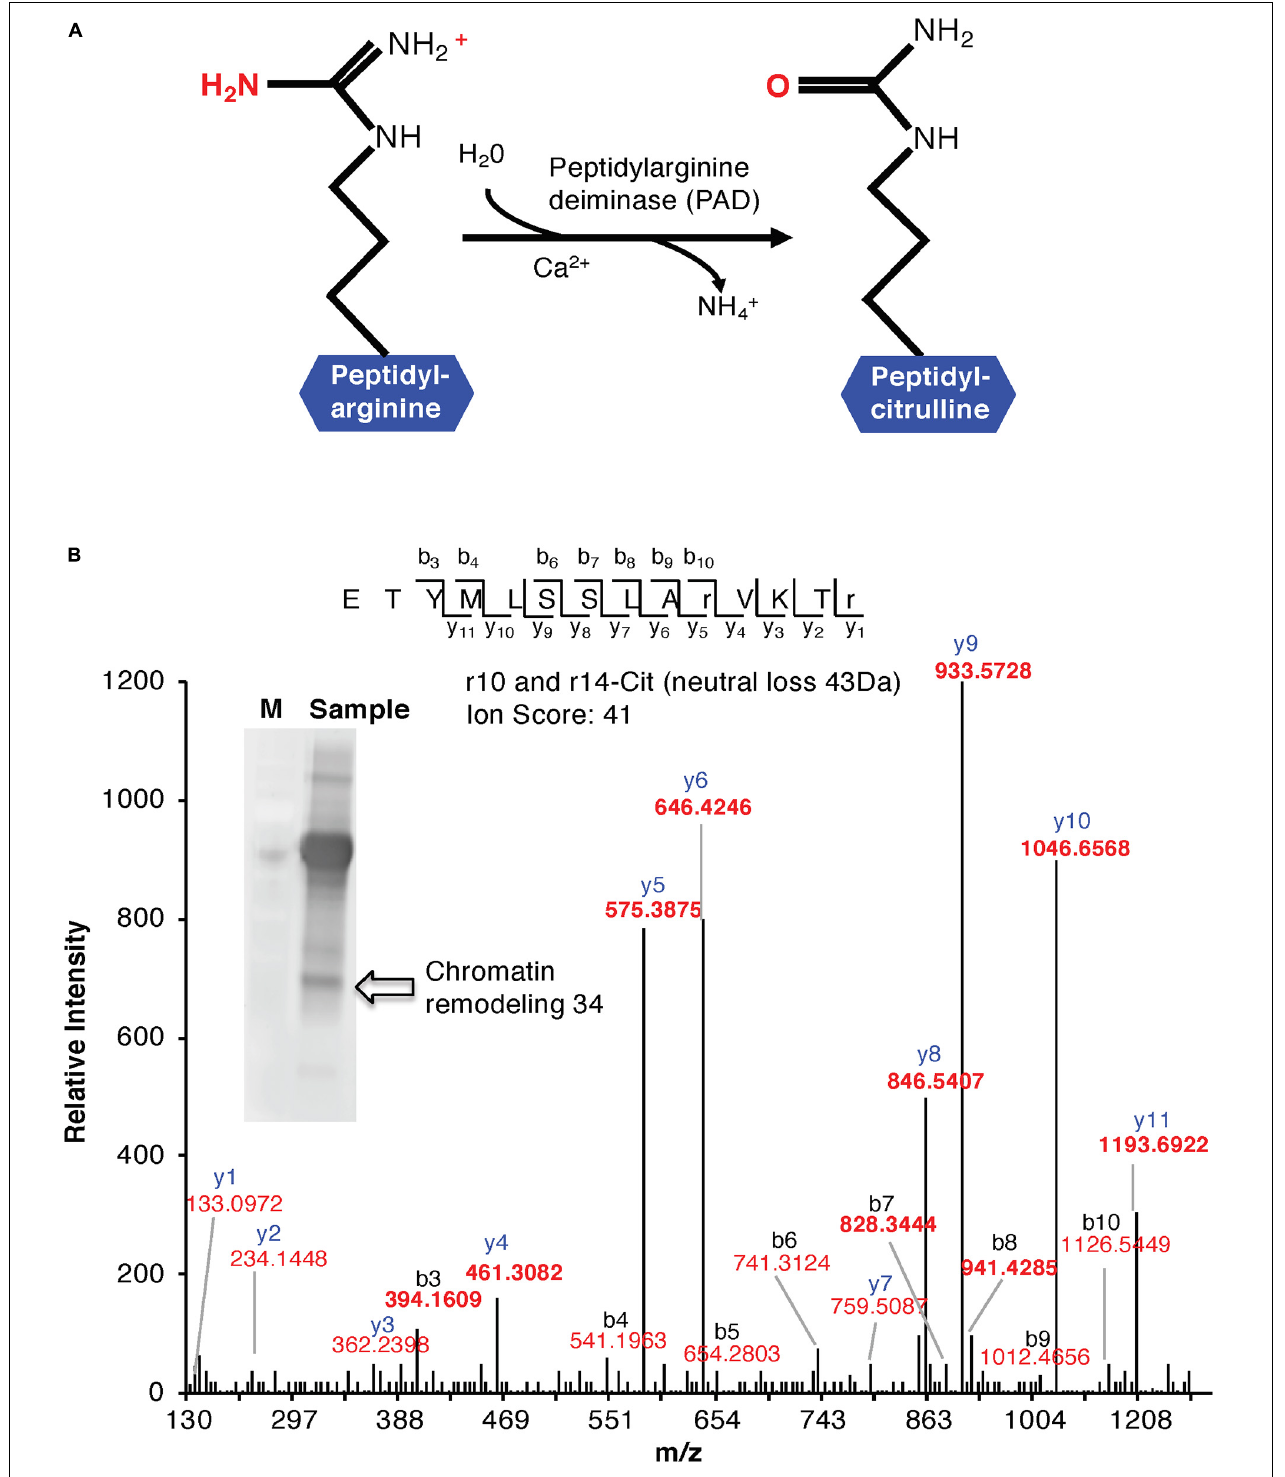
FIGURE 1 | (A) Enzymatic formation of a citrulline. Enzymatic hydrolysis of peptidyl-arginine to peptidyl-citrulline by peptidylarginine deiminase (PAD). (B) MS/MS spectra of a citrullinated Chromatin Remodeling 34 (ChR34). The MS/MS spectrum of Chromatin Remodeling 34 (At2g21450) contains citrullinated residues on positions 10 and 14. Indicated on the peptide sequence are the detected fragment ions, as indicated by the b - and y -ions and their relative intensities. The ion score of the peptide is 41. The insert shows a western blot of anti-citrulline immunoprecipitated proteins. The arrow shows the protein band identified as “Chromatin Remodeling